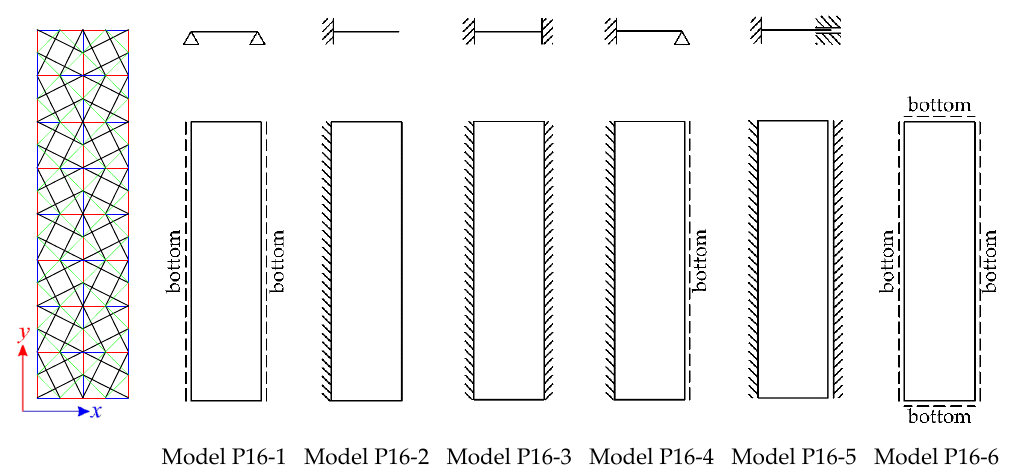
Figure 10. Sixteen-module tensegrity plate-like structure: ( a ) top view, ( b ) models. For all models, self-stress states ( S ) exist. One mechanism ( M ) is identified for models P16-1 and P16-6. Only superposed self-stress states correctly identified elements. None of the eigenvalues of the tangential stiffness matrix (cid:1785) (cid:3021)(cid:2869) for models P16-1 and P16-6 is non-positive, so the structures are stable and the identified mechanisms are infinitesimal. Except for the abovementioned features, all models are trusses ( T ) and their tensile elements are cables with no rigidity in compression ( C ). Models P16-1 and P16-6, due to the existence of the mechanism, are classified as structures with tensegrity features of class 1, while models P16-2–P16-5 satisfy the conditions of structures with tensegrity features of class 2 because of the absence of mechanisms.